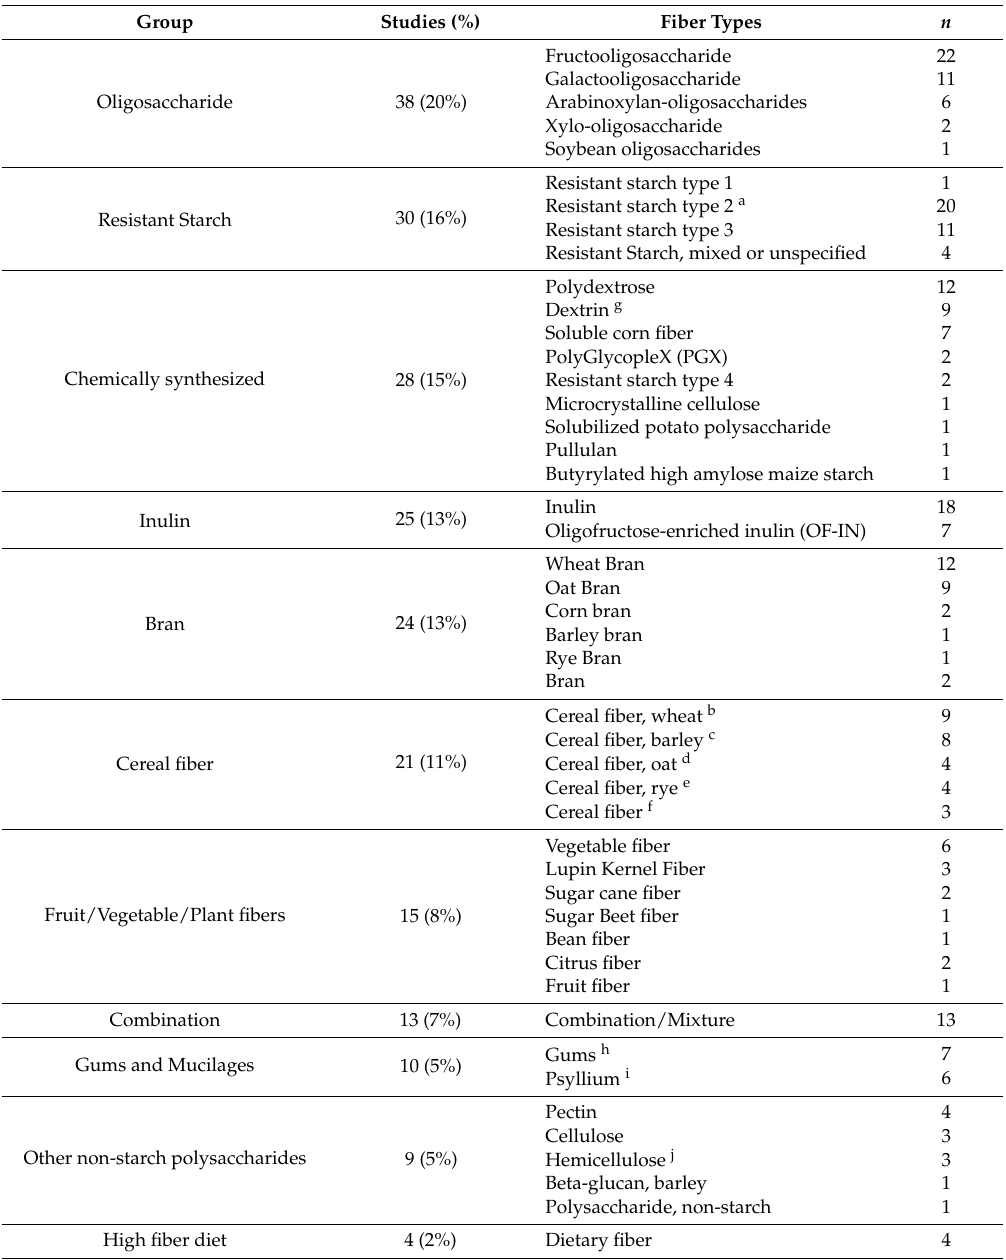
Table 2. Fiber types (total studies = 188), 324 unique